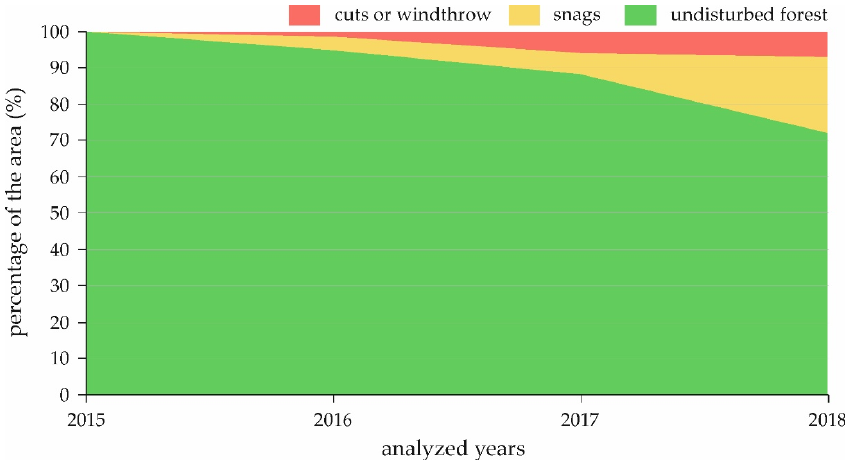
Figure 7. Share of undisturbed forest, snags and cuts/windthrow in the following years for the entire analyzed area.